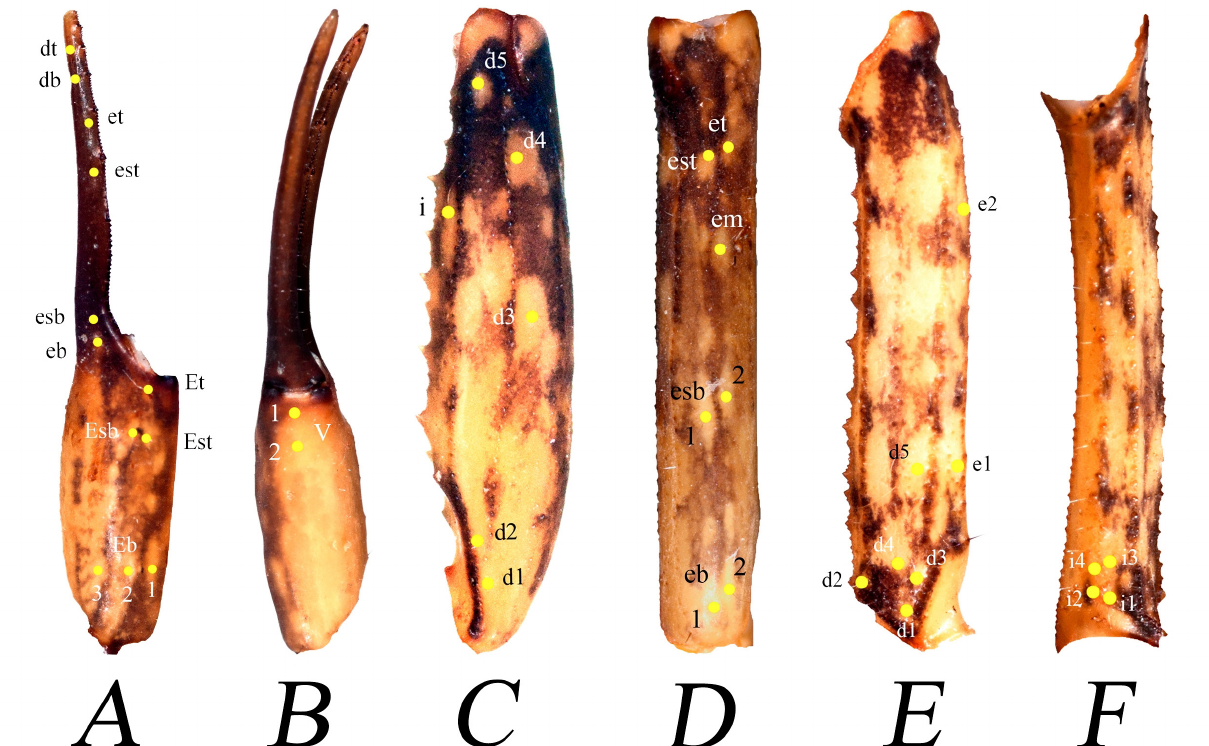
Fig. 15. Isometrus wayanadensis sp. nov., holotype, adult ♂ (BNHS SC 190). A–B . Pedipalp chela. A . Dorsal view. B . Ventral view. C–D . Patella. C . Dorsal view. D . External view. E–F . Femur. E . Dorsal view. F . Internal view. Trichobothrial pattern indicated by yellow